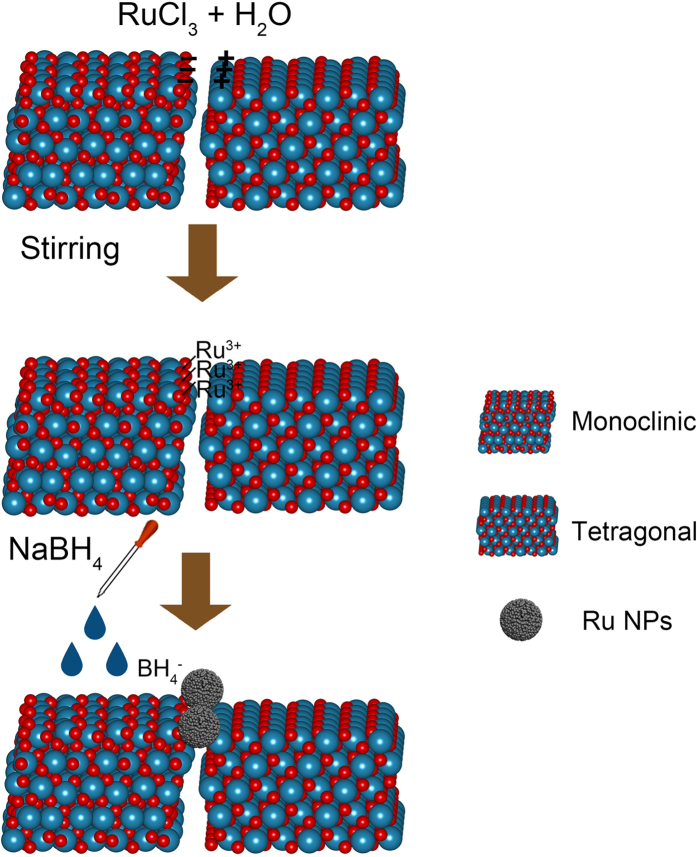
Illustration of the formation mechanism of the Ru NPs situated at the m-ZrO2/t-ZrO2 junction via chemical reduction method.